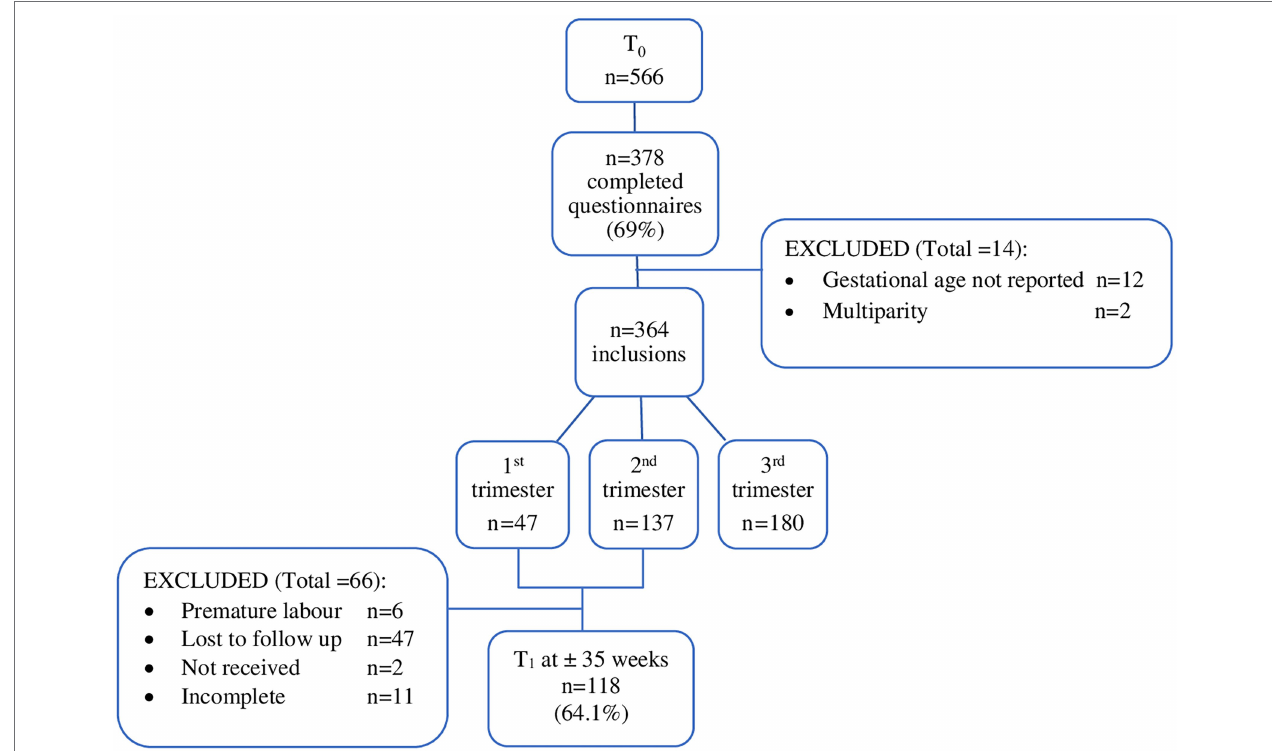
FIGURE 1 | Flow diagram participants. Flowchart of participants. For the longitudinal sample, two participants (i.e., “not received”) did not receive a questionnaire at